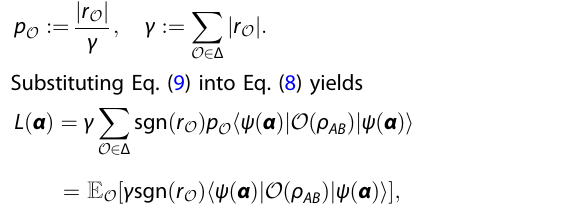
Algorithm 2 . Probabilistic VED 1: Input: 2 n -qubit quantum state ρ AB , decomposition in Eq. (1) of